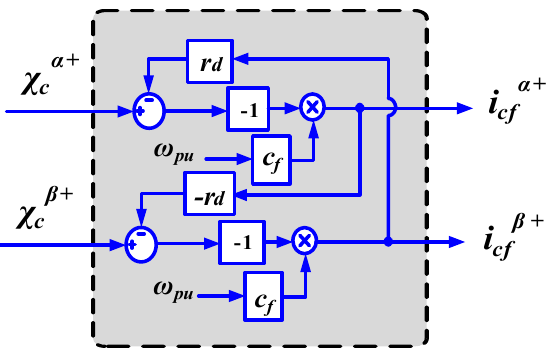
Figure 8. Estimation of positive sequence of capacitor current.